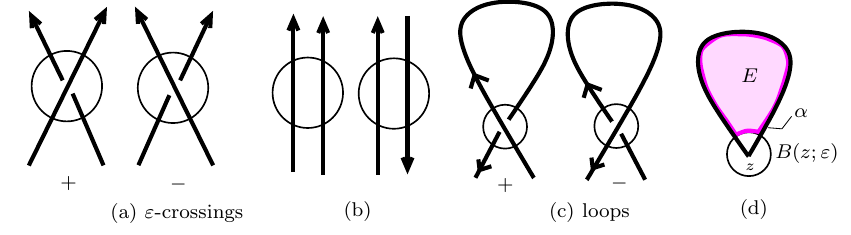
Fig. 6. Singed ε -crossings and